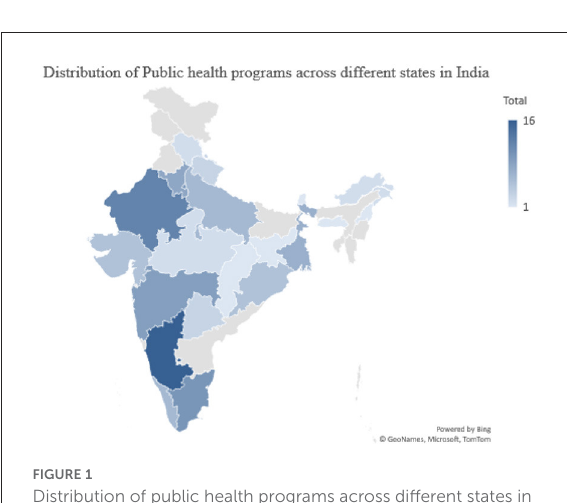
FIGURE1 Distribution of public health programs across different states in India.